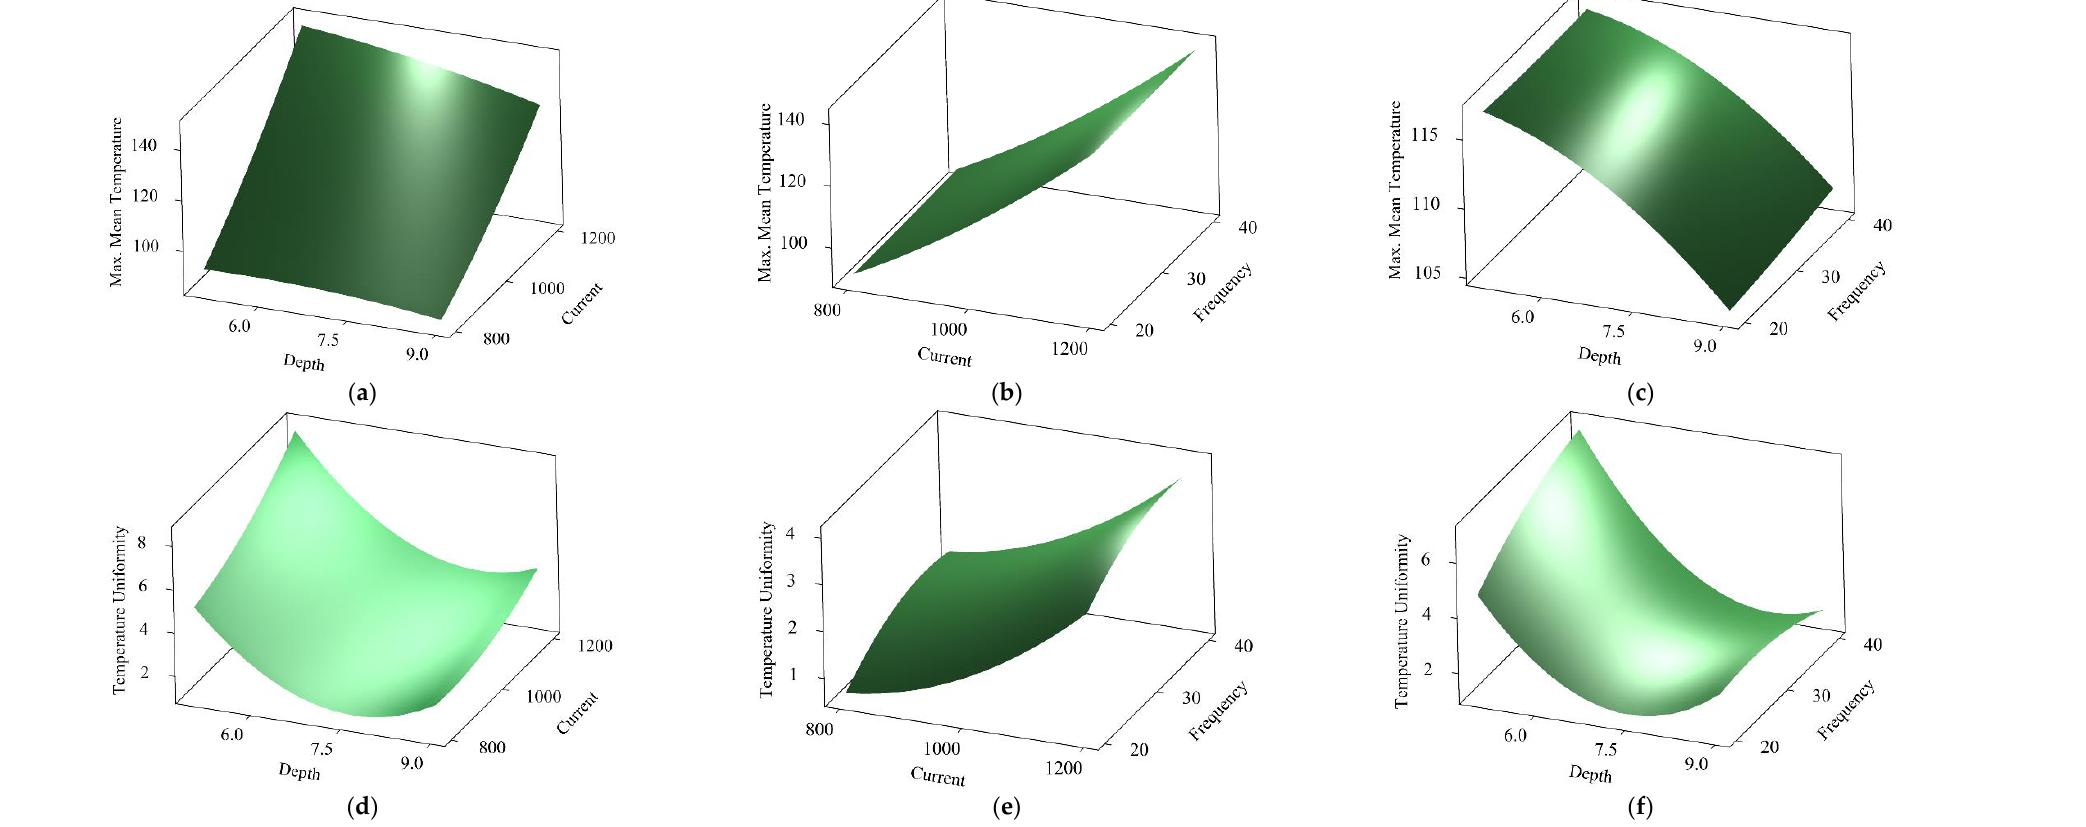
Figure 6. Response surface diagrams for the synergistic effect of different parameters on target results: ( a ) interaction of depth and current on max. mean temperature; ( b ) interaction of frequency and current on max. mean temperature; ( c ) interaction of depth and frequency on max. mean temperature; ( d ) interaction of depth and current on temperature uniformity; ( e ) interaction of frequency and current on temperature uniformity; ( f ) interaction of depth and frequency on temperature uniformity.